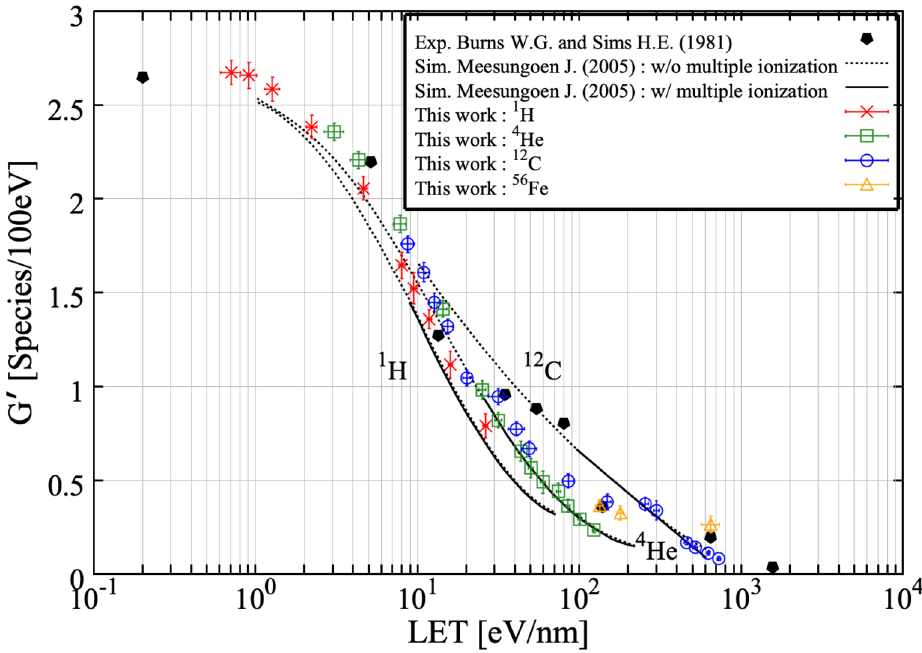
Figure 7. LET dependent G-values of · OH at 1 μs after irradiation of a water target with different radiation types. The solid lines presented by Meesungunoen J. and Jay-Gerin J.P. represent the results of Monte Carlo simulations incorporating multi-ionization of water. The short-dot lines presented by by Meesungunoen J. and Jay-Gerin J.P. correspond to simulated G-values calculated as a function of LET without including the mechanism of multi-ionization of water 47 . Experimental data presented by Burns W.G. and Sims H.E. 50 were used for comparison with simulated LET dependence of